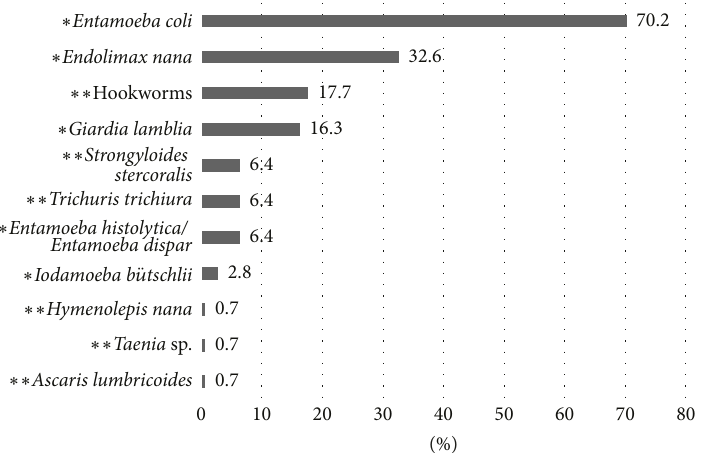
36 ). The Paraguai river was their primary water source.